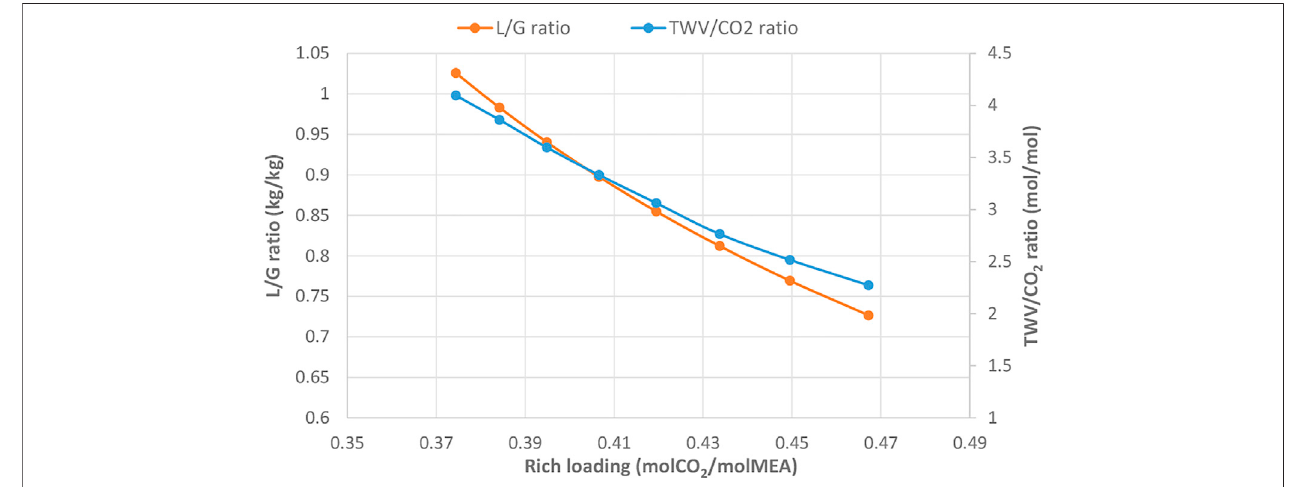
FIGURE 6 | L/G ratio and TWV/CO 2 ratio as a function of rich loading. Lean loading is 0.15 molCO 2 /molMEA and stripper pressure is 1.5